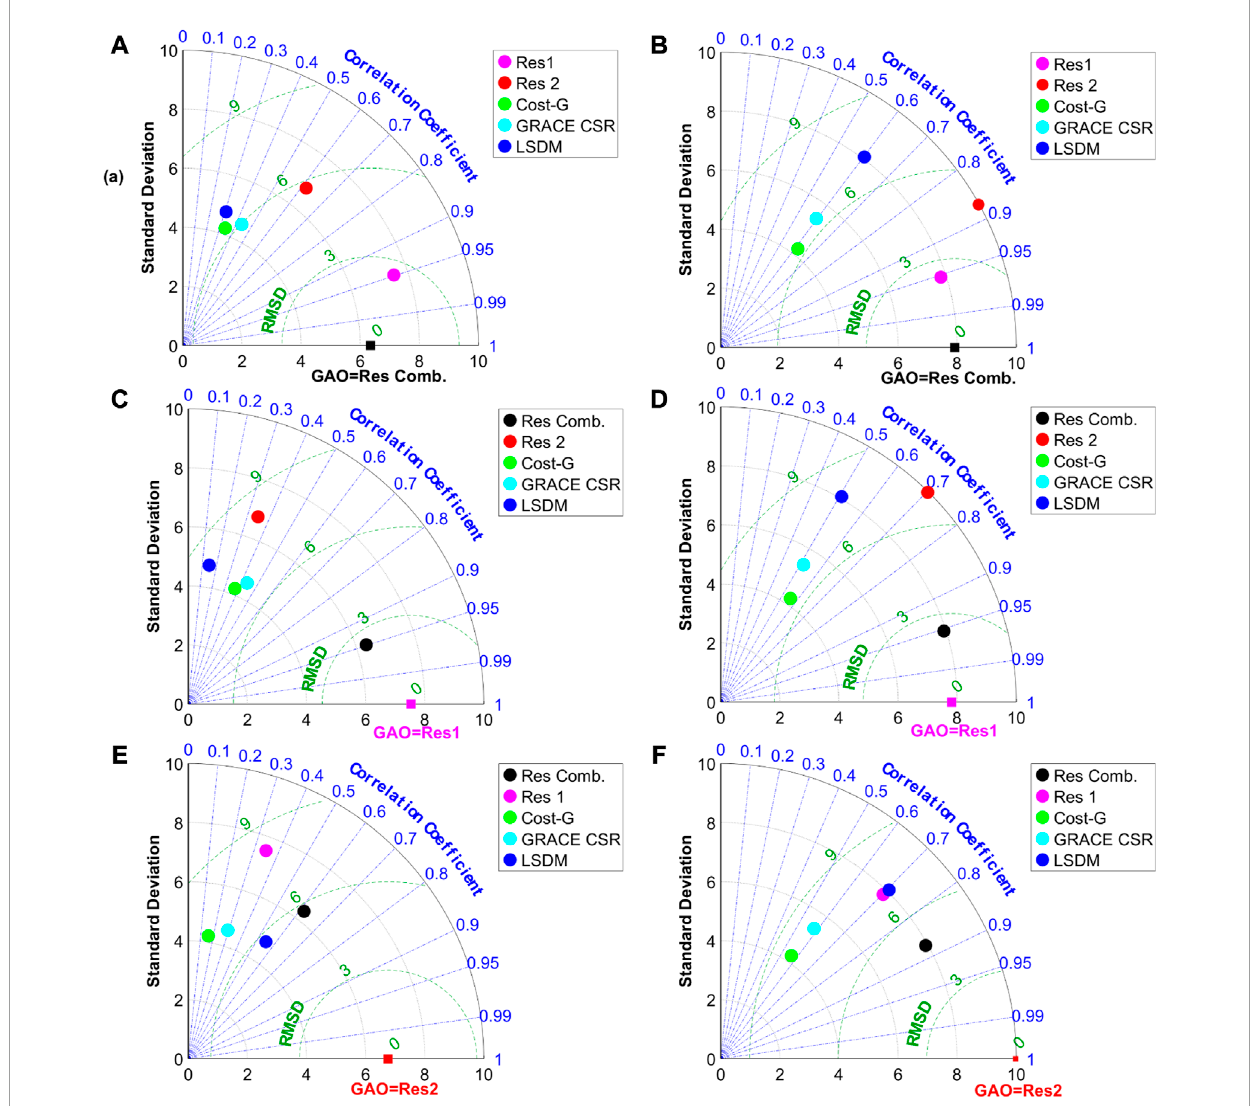
FIGURE 5 Taylor diagrams showing a comparison of χ 1 and χ 2 overall detrended components of three different geodetic residuals as a reference vlaues: (A) χ 1 of Res Comb. (B)